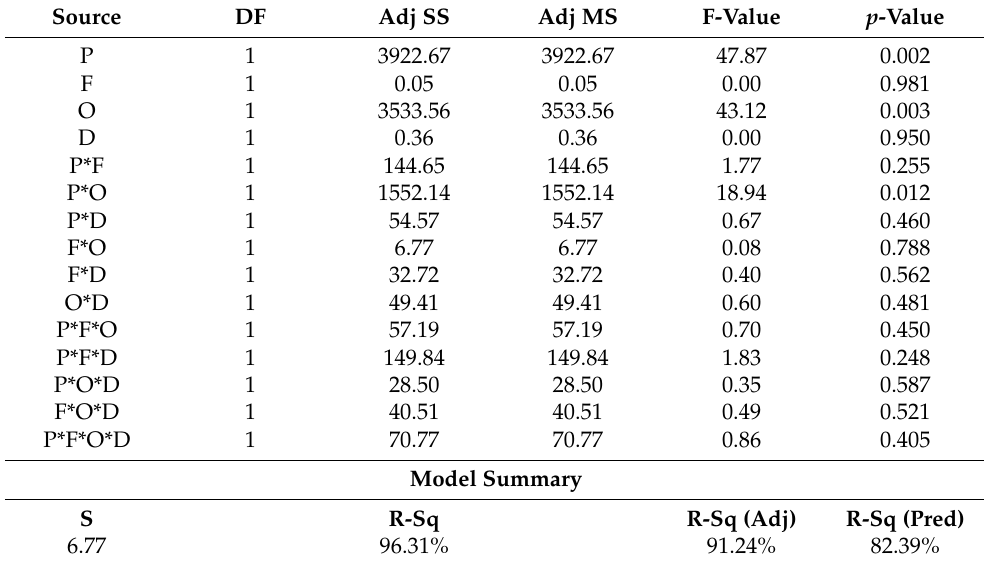
Table 8. Analysis of variance for deep rolling.